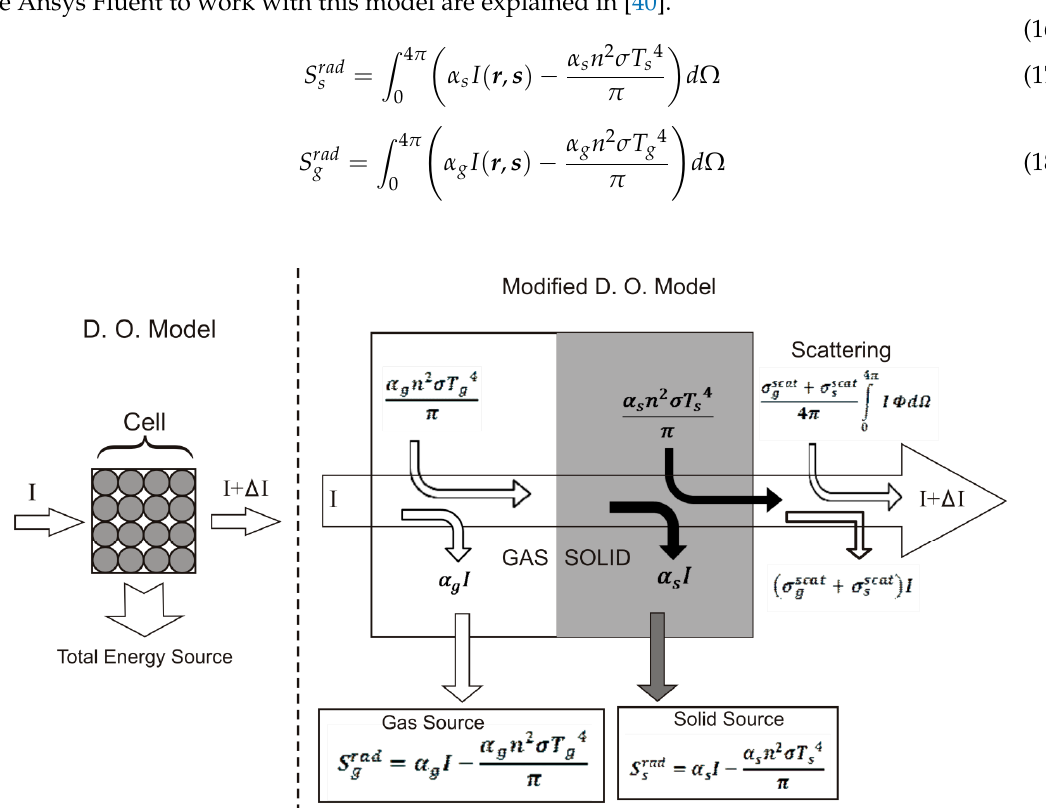
Figure 2. Scheme of the modification of the D.O. radiation model for a direction [40] .